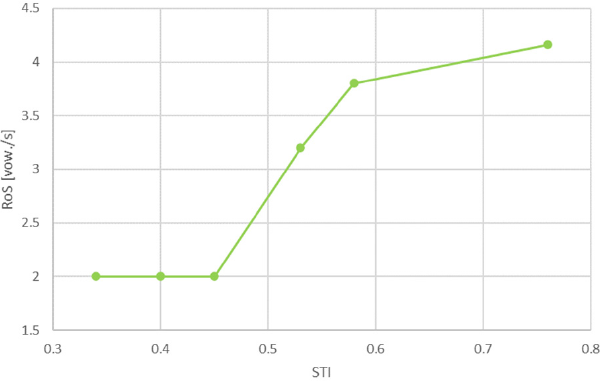
Figure 5. Developed curve showing RoS values as a function of the STI.